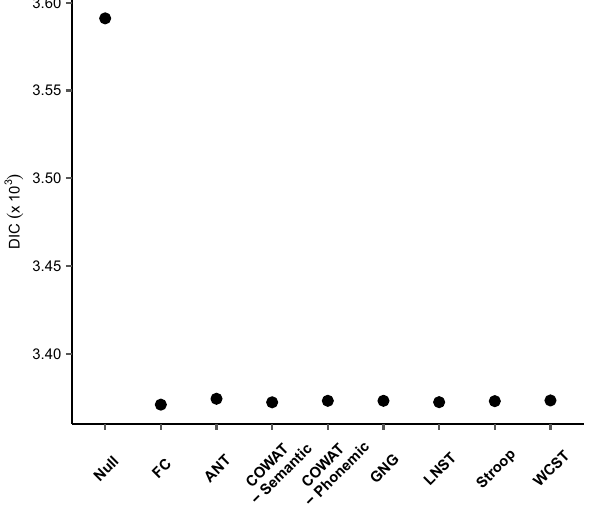
Figure 3. DIC values for nine candidate models with regard to seven neuropsychological test performances. DIC values for the Null model, the FC model, and seven Full models for each neuropsychological test are shown. Here, lower values indicate better fits. The FC model and seven Full models outperformed the Null model, but the differences between the FC model and the Full models are marginal. Models are displayed in alphabetical order after two base models ( Null and FC model). ANT attention network test, COWAT controlled oral word association test, GNG go/no-go, LNST letter number sequencing task, WCST Wisconsin card sorting test.